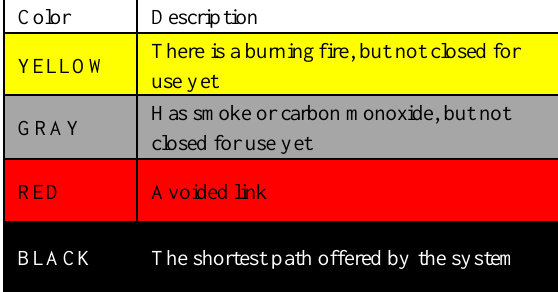
Table 10. Color descriptions in the simulation.